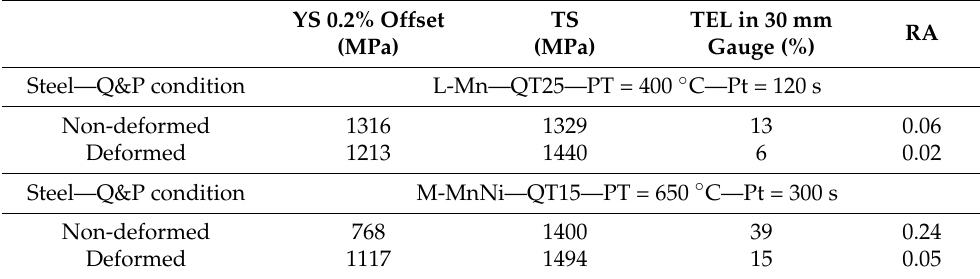
Table 4. Tensile properties and retained austenite fractions obtained from the deformed and non- deformed areas of Omega parts of M-MnNi steel partition-treated at 650 ◦ C and of L-Mn steel partition-treated at 400 ◦